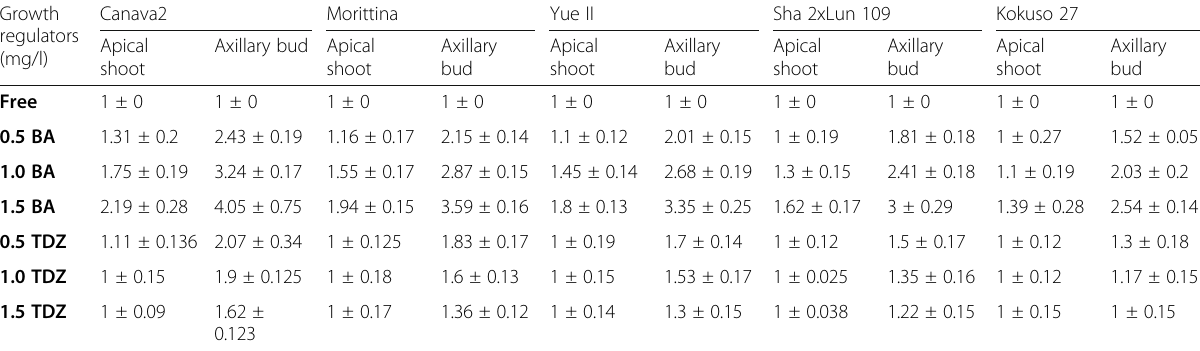
Table 2 Effect of BA or TDZ (mg/l) at different concentrations and type of explants (apical shoots or auxiliary buds) on in vitro number of shoots/ explant produced from kantava 2, morittina,yue 11, sha 2x lun 109, and kokuso 27 mulberry cultivars Growth regulators